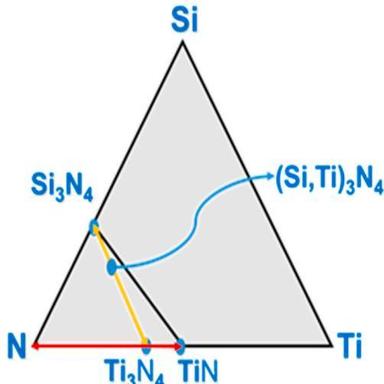
SiTiN ternary composition diagram with the known binary subsystems and the novel ternary SiTiN phase located on the tie line between γ-Si3N4 and c-Ti3N4. The ternary γ-(Si,Ti)3N4 phase partitions first into γ-Si3N4 and Ti3N4. Ti3N4 is thermodynamically unstable under our experimental conditions of 15–20 GPa and 1800–2000 ◦C. Thus, Ti3N4 readily decomposes into the thermodynamically stable phases c-TiN and gaseous N2 along the tie line of the binary Ti–N subsystem .